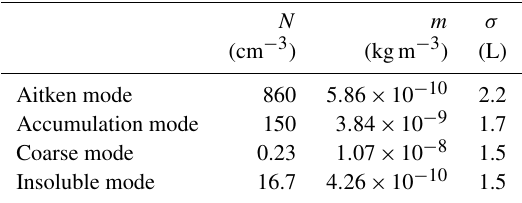
Table A1. Aerosol number concentration ( N ), mass density ( m ), and width of the size distribution ( σ ) prescribed as lateral boundary and initial conditions in the boundary layer.